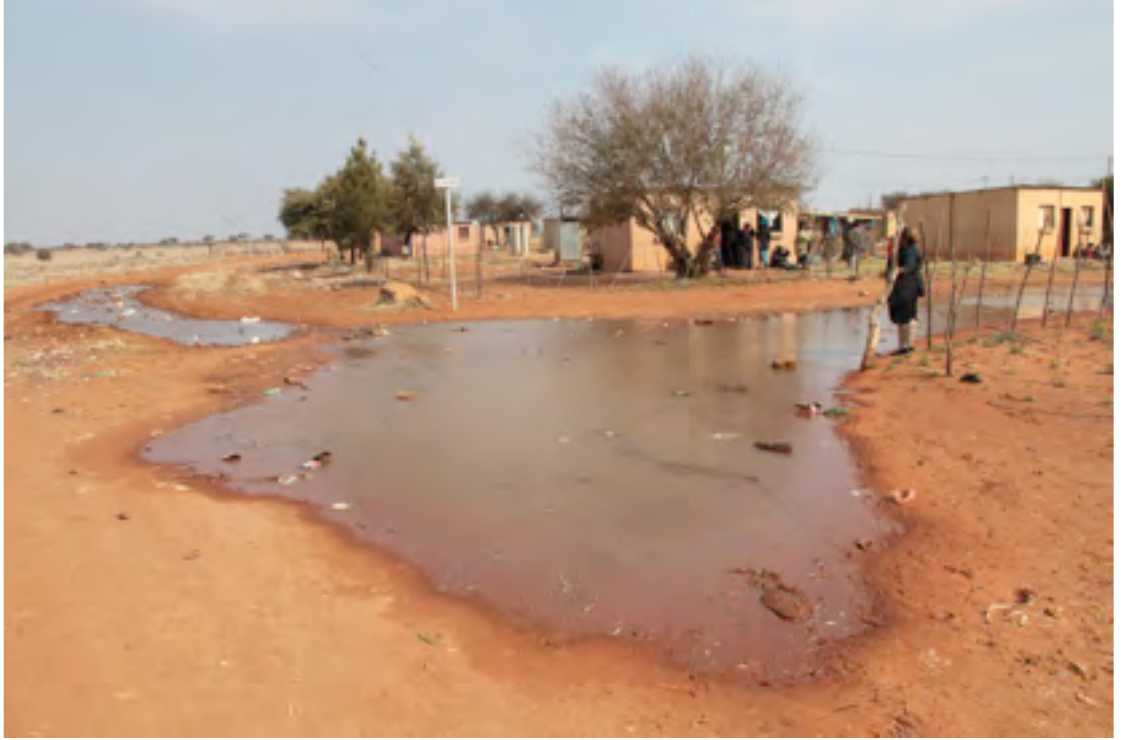
Figure 10 Motorists are unable to use the Chere Street T-junction road for fear of damaging their vehicles in the leaking water on site. (Photograph: JWN